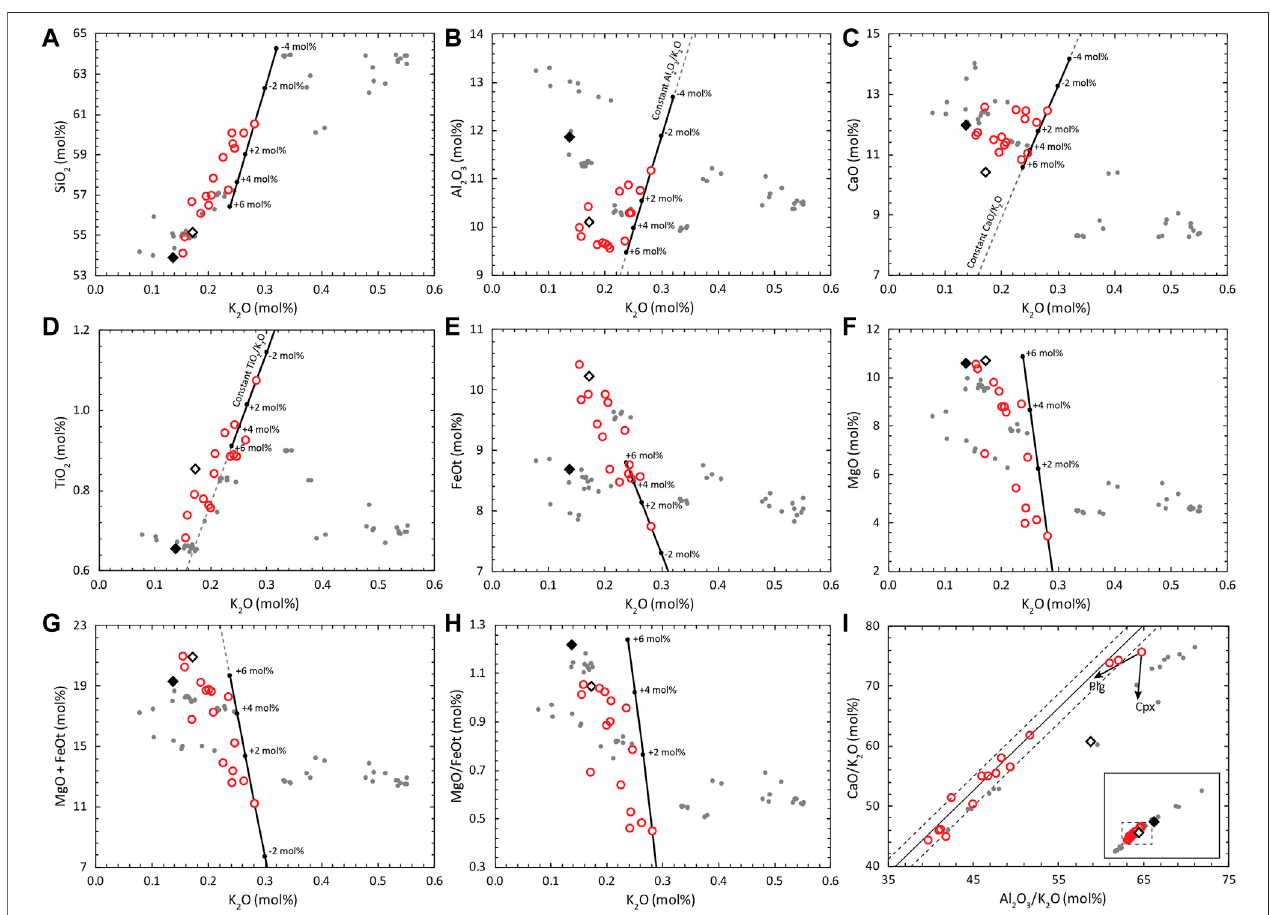
FIGURE 7 | Variation diagrams of major element components (in mol%) of the MIs of the AK sample. Red Circles are the uncorrected MI compositions, the fi lled black diamond indicates the whole rock composition of the sample from which the MIs were collected, the hollow diamond corresponds to the AK melt fraction composition estimated through mass balance, and the grey dots are whole rock data of the AK volcanic system from the compilation found in Kuritani et al. (2019). The blacklinewithcirclesisthetrendofolivineadditionforoneoftheMIs,whereproportionsofadditionareindicatedfor-4,-2,2,4and6 mol%.Thecompositionofthe olivine has no effect in the olivine addition trend for (A) to (D) and (G) , whereas an olivine composition of Fo 78 was used to calculate the trends in (E) and (F) . Fractional crystallizationtrendsin (I) areunaffectedbyolivinefractionation,i.e.theydonotchangewithPECofolivineintheMIrims.Greycontinuouslinein (I) isthelinearregression of the MI data, and the dashed lines mark the standard deviation ( ± 1 σ ). Arrows in (I) indicate approximated trends of fractionation of plagioclase and clinopyroxene. Dashed grey lines indicate constant ratios of conservative elements during olivine addition/subtraction.